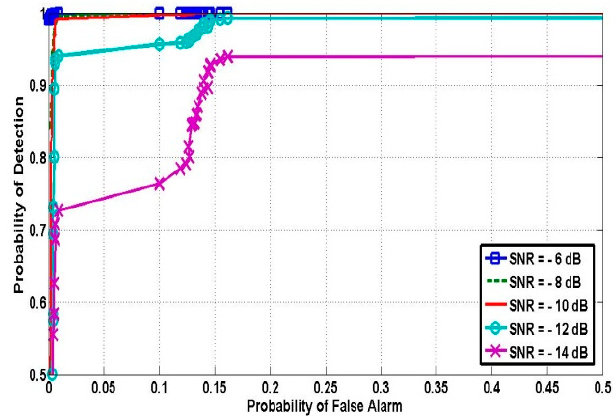
Figure 7. Receiver operating characteristic (ROC) curves of the proposed scheme under various SNRs.